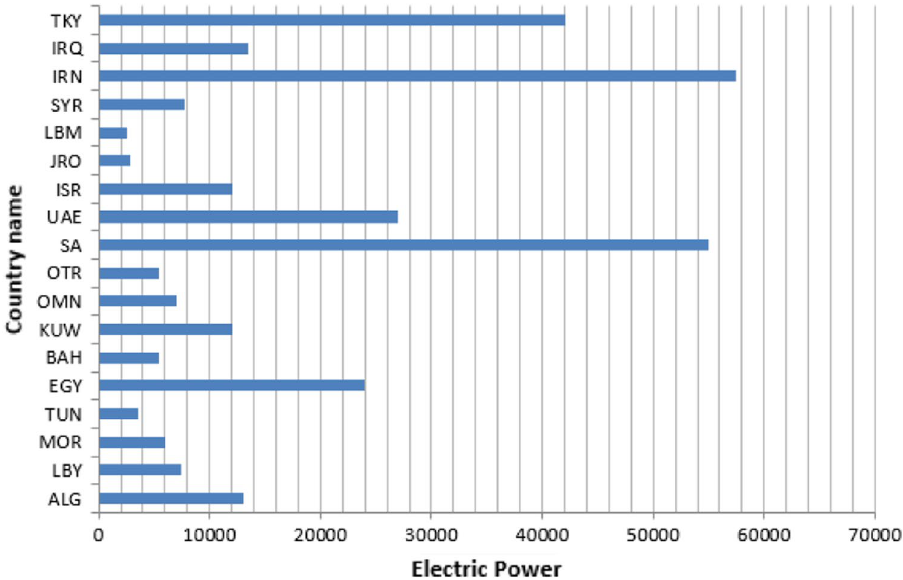
Fig. 5 Consumed electric power per country in MENA